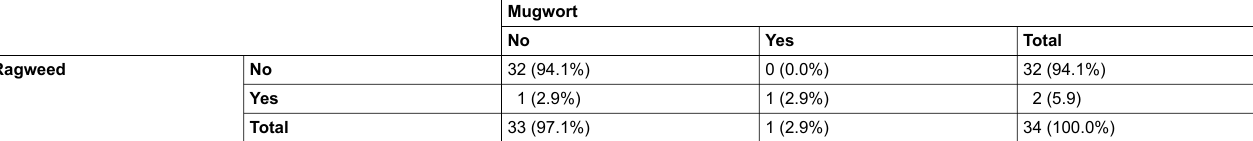
Table 3: The prevalence of sensitisation to ragweed and mugwort was calculated with the 95% confidence intervals of the proportion which were assessed by the exact method of Clopper-Pearson. One missing value for ragweed.